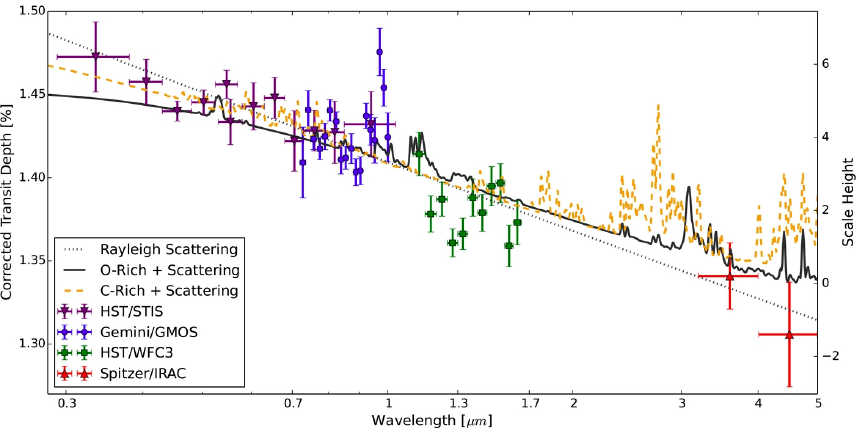
Figure 11. A transit spectrum for WASP-12b, showing how the transit depth varies with wavelength. The figure also shows some models based on different atmospheric compositions. The actual composition is not clear, but there appears to be some scattering, and the models rule out a featureless, pure hydrogen atmosphere. (Figure from